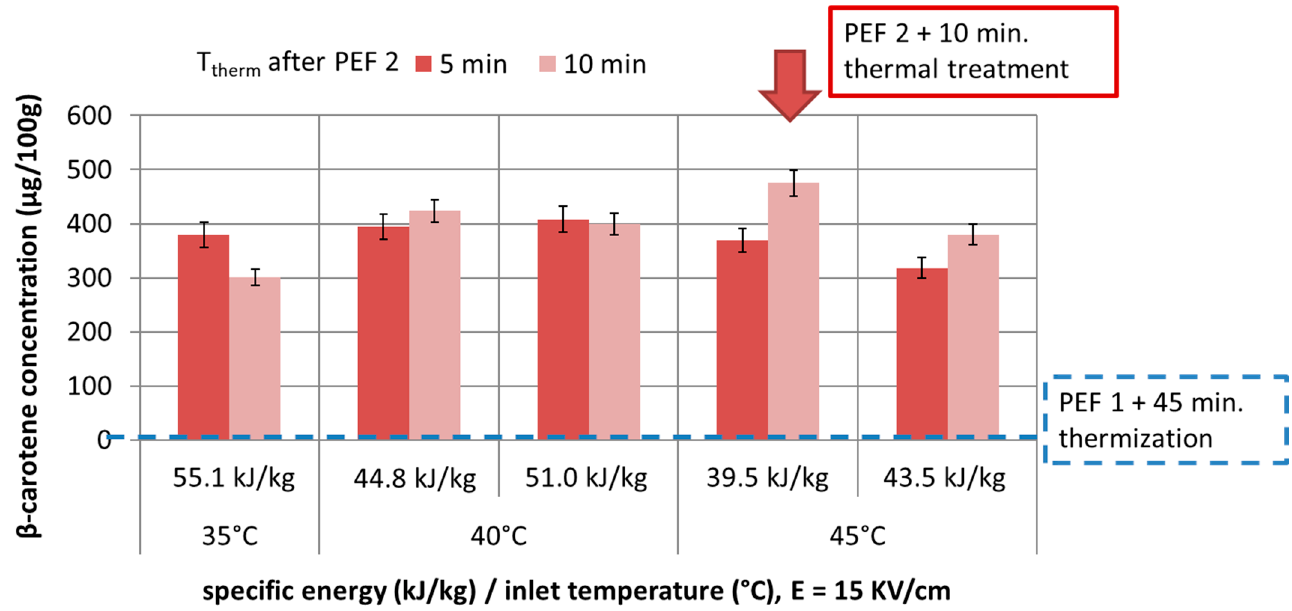
Figure 7. β -carotene content in PEF-assisted thermization (PEF 2) of CM after being previously disintegrated by PEF (PEF1).